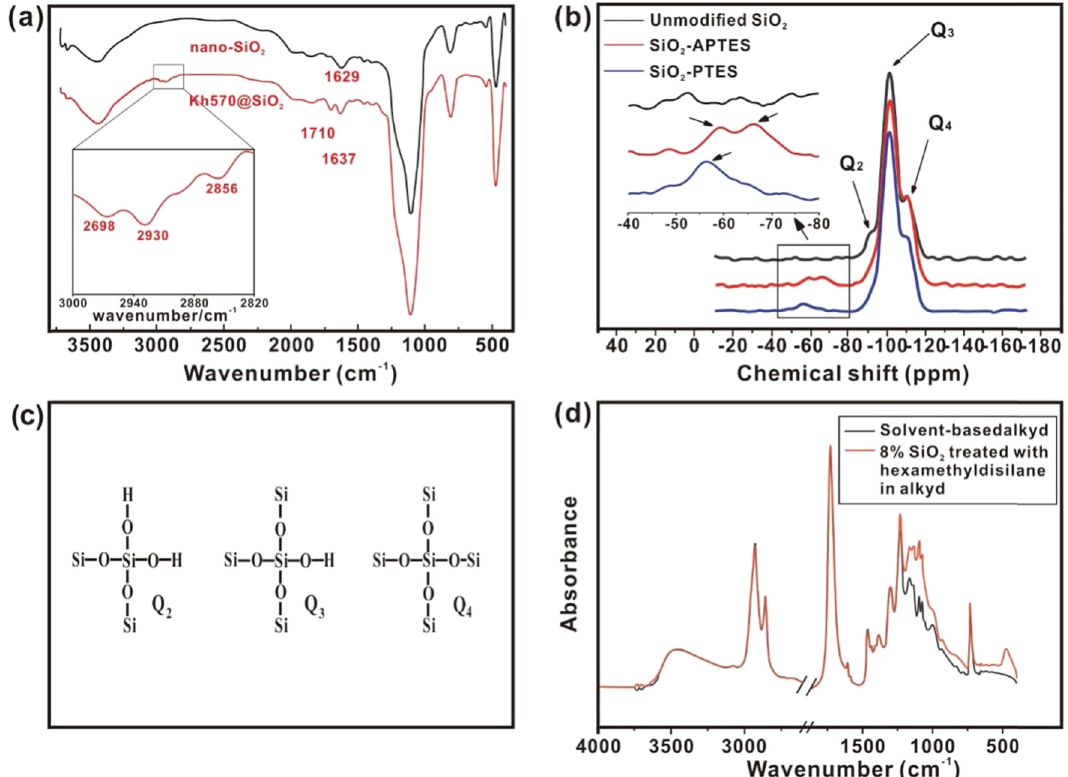
Figure 5: ( a ) FTIR spectra of SiO 2 and KH570 modi fi ed SiO 2 [ 61 ] ; Copyright: 2020 with permission from Elsevier Science SA, ( b ) Si solid -